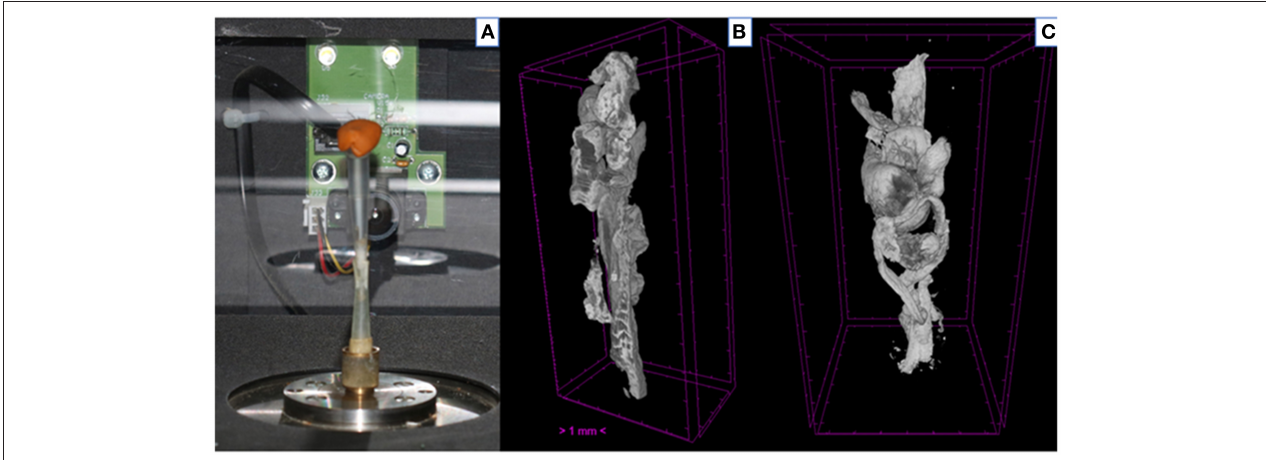
FIGURE 1 | Thrombus analysis via micro-computed tomography. (A) Thrombi are mounted on a specific head inside SkyScan 1172; (B,C) Representative computer generated renderings of thrombi. Clots were stained using 0.3% phosphotungstic acid and scanned via SkyScan 1172. NRecon (Bruker, Kontich, Belgium) software was used for the reconstruction of the projections.